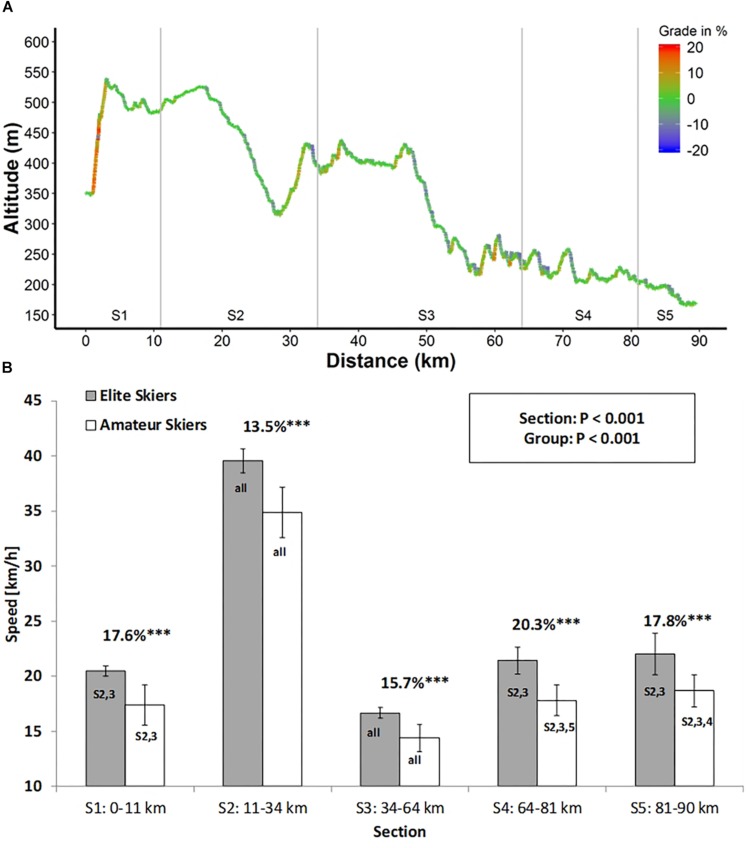
(A) Track profile of the 90-km Vasaloppet and (B) section speeds for both groups and percent difference between groups in mean speed; S1, S2,…, S5, section 1, section 2,…, section 5; ***P < 0.001, significantly different to amateur skiers (mean ±SD). S1, 2,.…,5, significantly different to the respective section within each group.